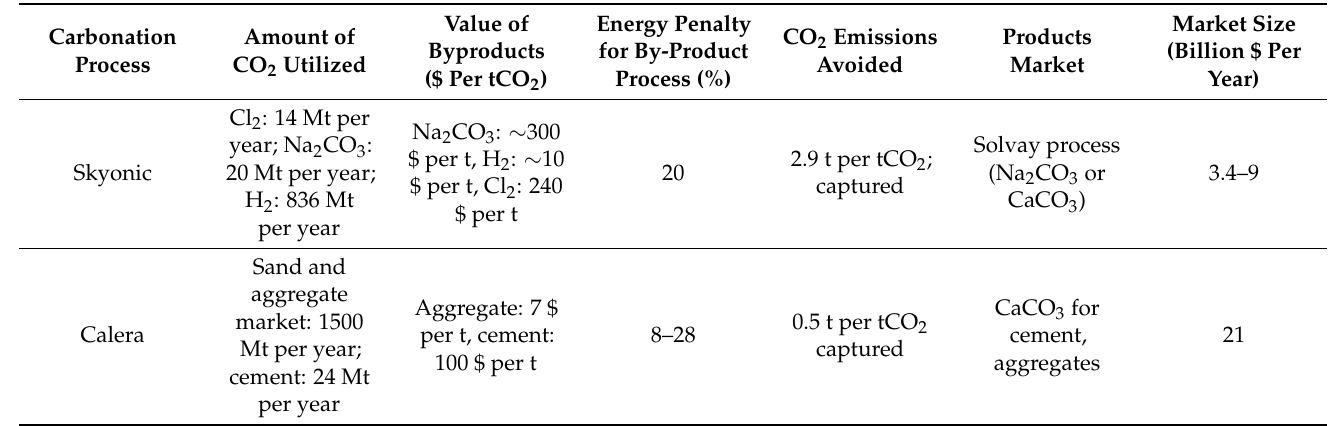
Table 4. Use of Carbonation Products, adapted from Sanna et al.